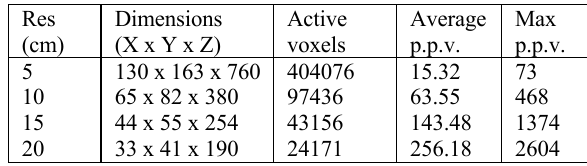
Table 7. Effects of different voxel resolutions